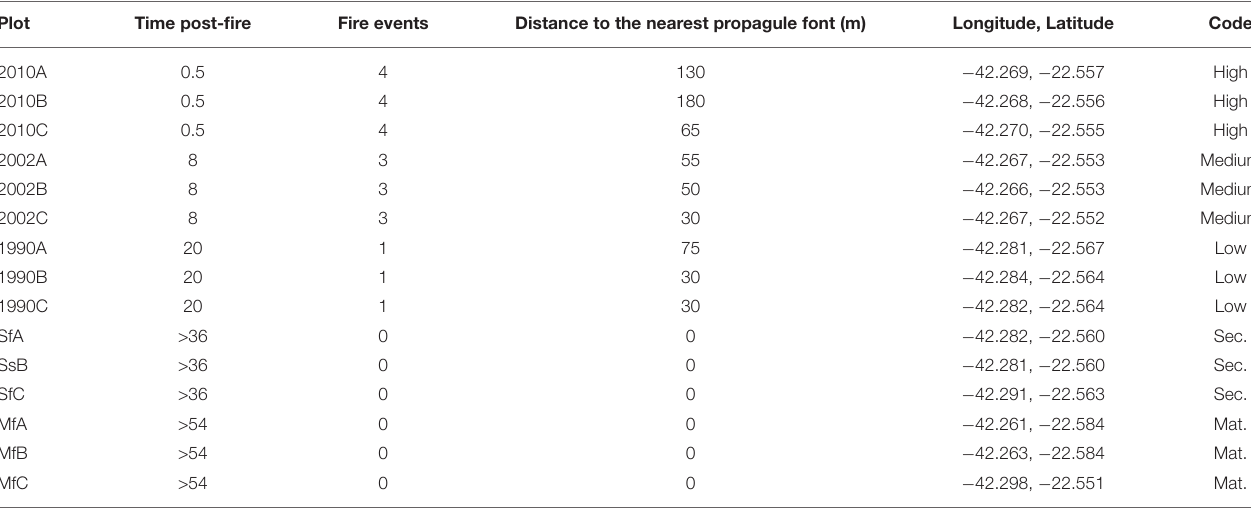
TABLE 1 | Environmental factors that compose the complex fire gradient. Plot